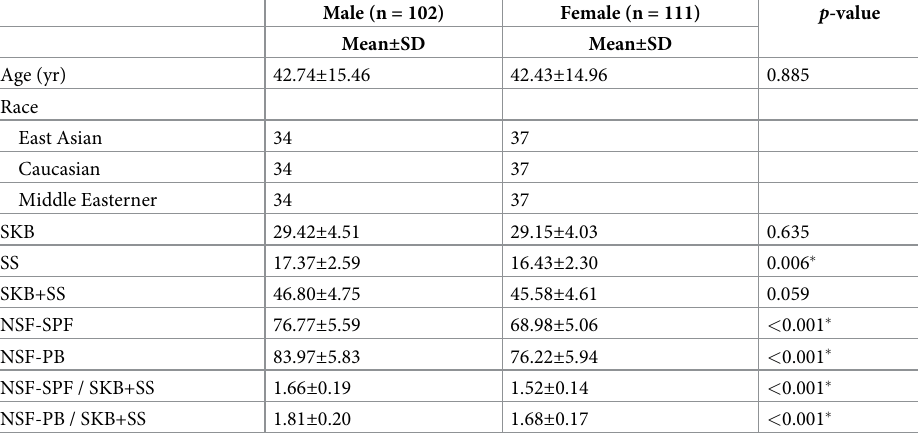
Table 4. Summary of patient characteristics and CT measurements by sex.